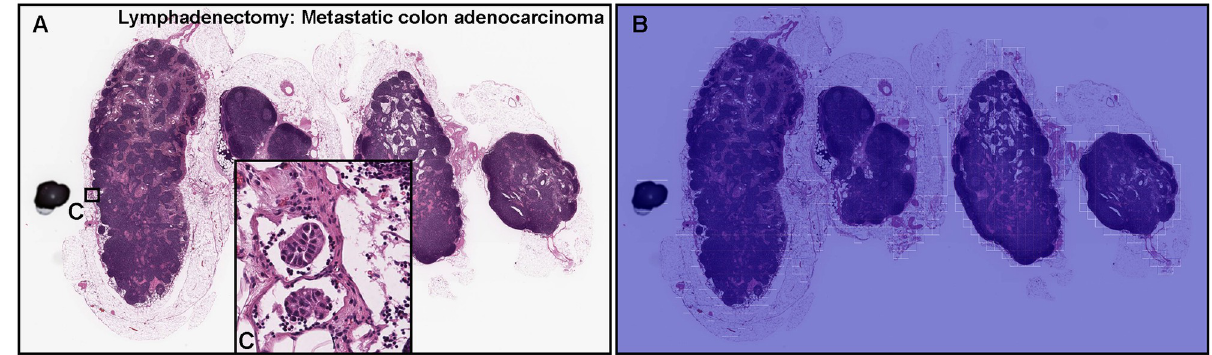
Fig 7. Representative example of metastatic adenocarcinoma false negative prediction output on a case from the radical lymph node dissection (lymphadenectomy) test set using the model (WS-4K: 224, x10 EfficientNetB1). According to the histopathological diagnostic report, this case (A) has metastatic adenocarcinoma foci in (C) but not in other areas. The heatmap image exhibited no positive adenocarcinoma prediction (B). The heatmap uses the jet color map where blue indicates low probability and red indicates high probability.